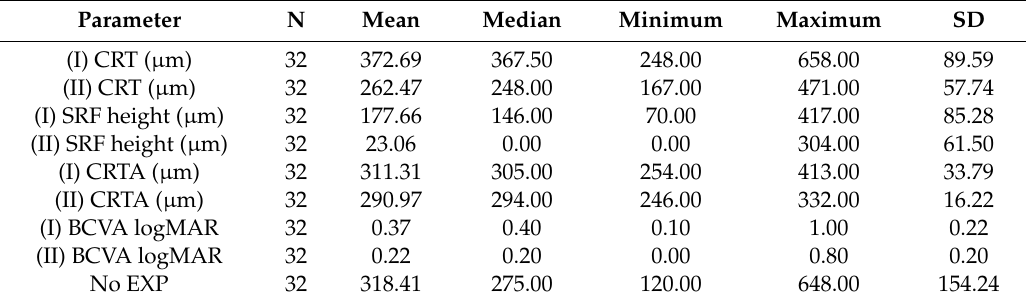
Table 2. Study group baseline characteristics and results of subthreshold micropulse laser treatment (SMPLT).